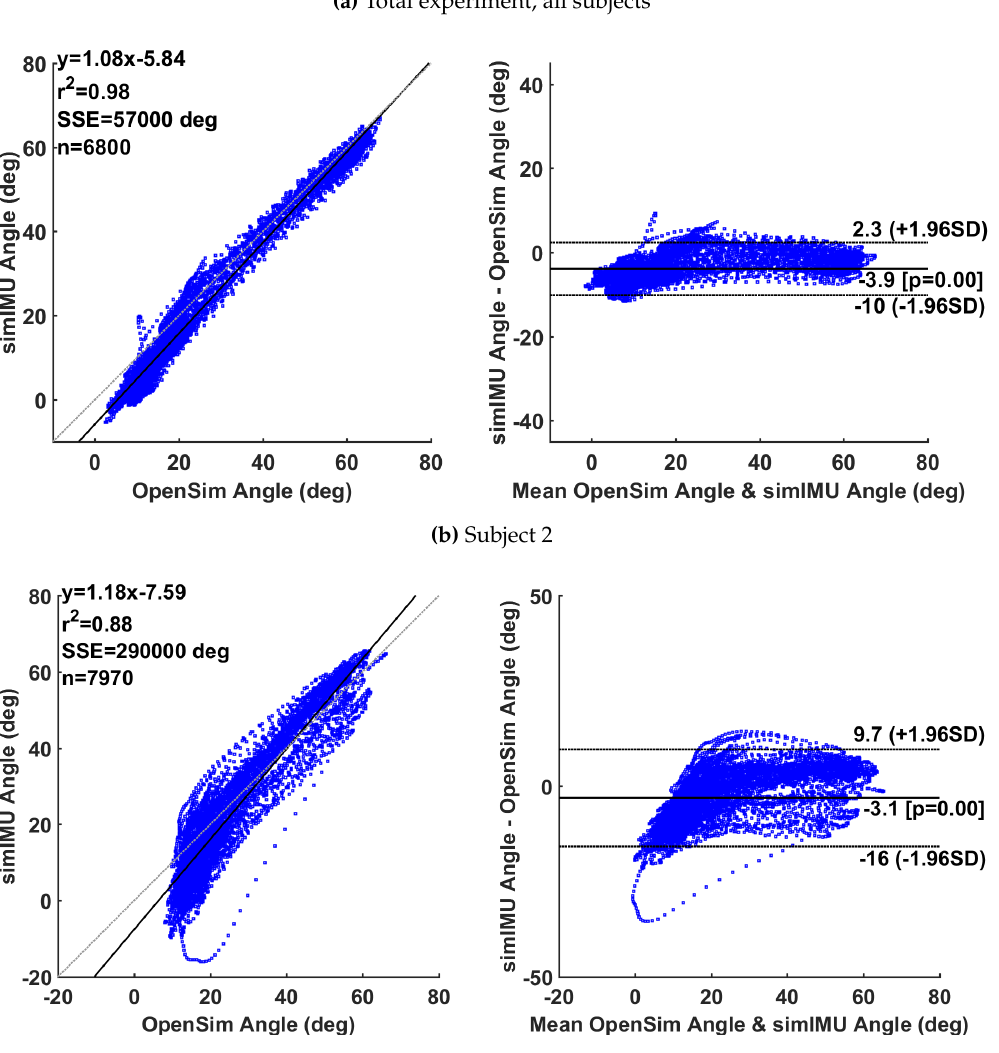
Figure 5. Selected Bland–Altman analyses; linear model given by y ( x ) with associated squared correlation coefficient r 2 , including sum of squared error (SSE) over n data points. Estimated data is the knee angle according to the proposed method on the simulated IMU